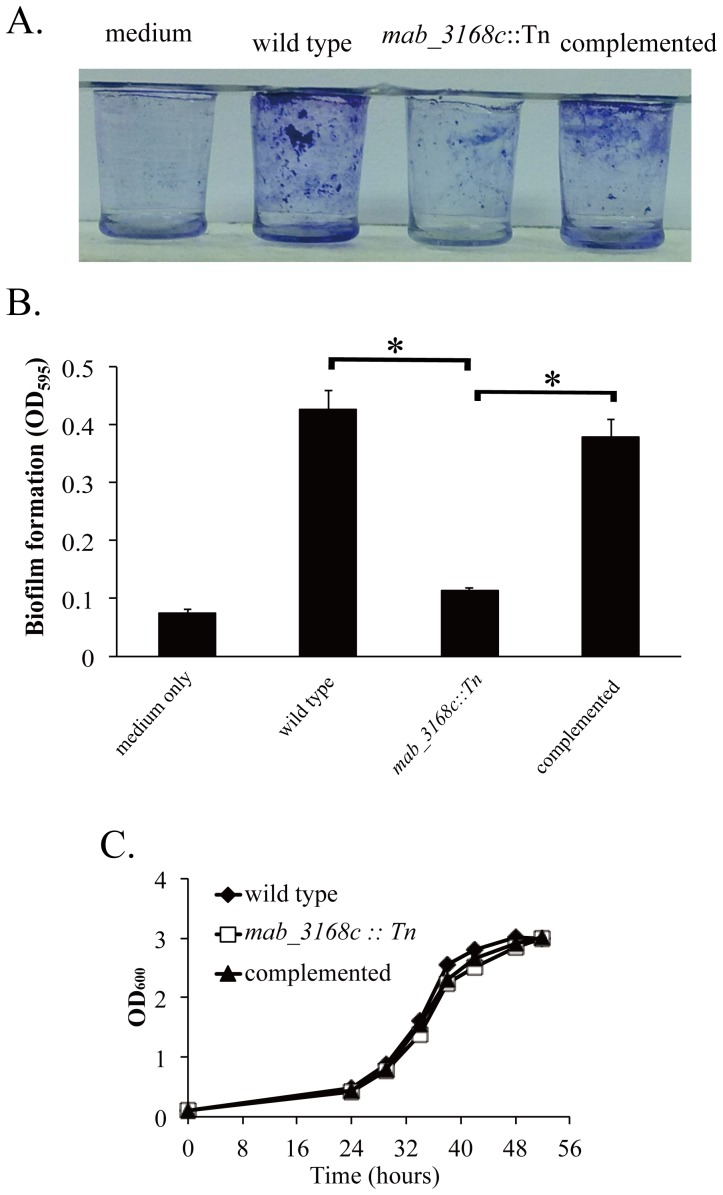
Biofilm-forming capability of M. abscessus cells.(A) Cultures of wild type, mab_3168c::Tn, and complemented strains were grown on 96-well PVC plates for 6 days. The plates were washed and then stained with crystal violet. (B) Optical density readings of the three strains shown are means ± standard deviations of three independent experiments. Data were analyzed by one-way ANOVA and Fisher’s PLSD test. The asterisk sign (*) represents p<0.05 of mab_3168c::Tn versus wild type or mab_3168c::Tn versus complemented strain. (C) Growth rates of M. abscessus variants. Cells were grown in 7H9 medium supplemented with OADC (10%) and Tween 80 (0.05%), and the OD600 value of each culture was measured at the indicated time points.